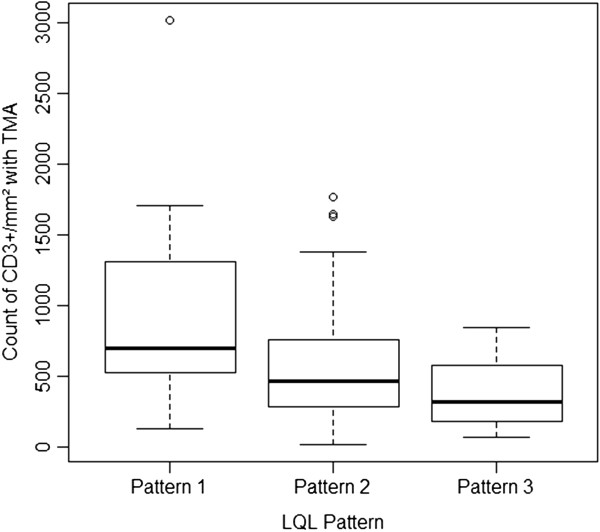
Distribution of CD3+ density according to the LQL pattern.